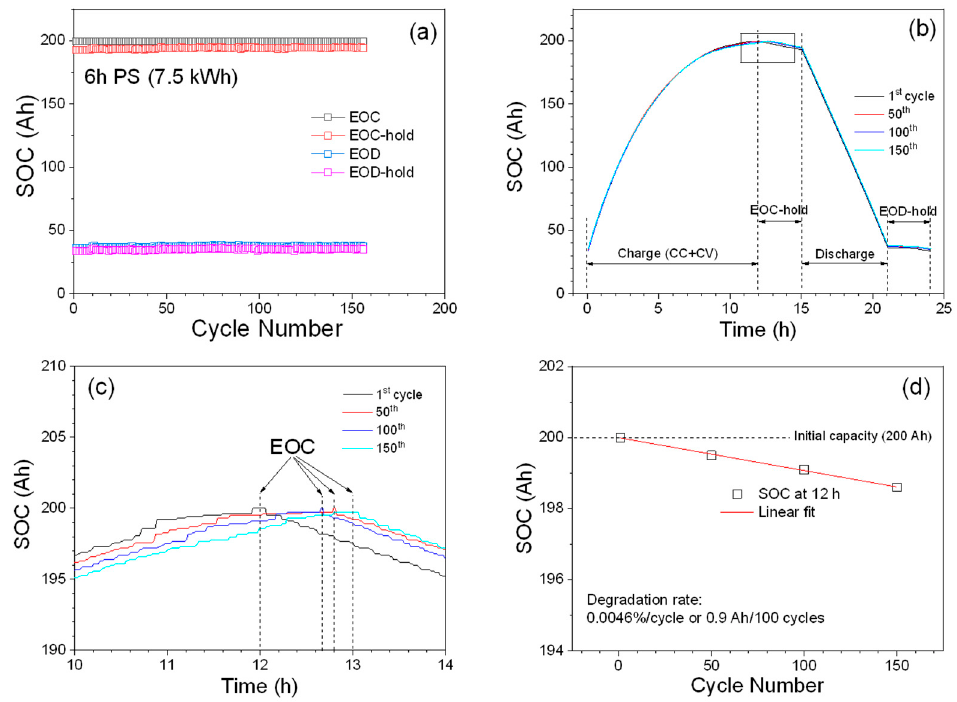
Figure 4. Long-term testing of the module under the 6 h peak-shaving schedule. ( a ) SOC vs. cycle; ( b ) comparison of SOCs for the 1st, 50th, 100th, and 150th cycles; ( c ) zoom-in SOC plots (area marked by a square in b) of the 1st, 50th, 100th, and 150th cycle; ( d ) capacity degradation rate for the charge.